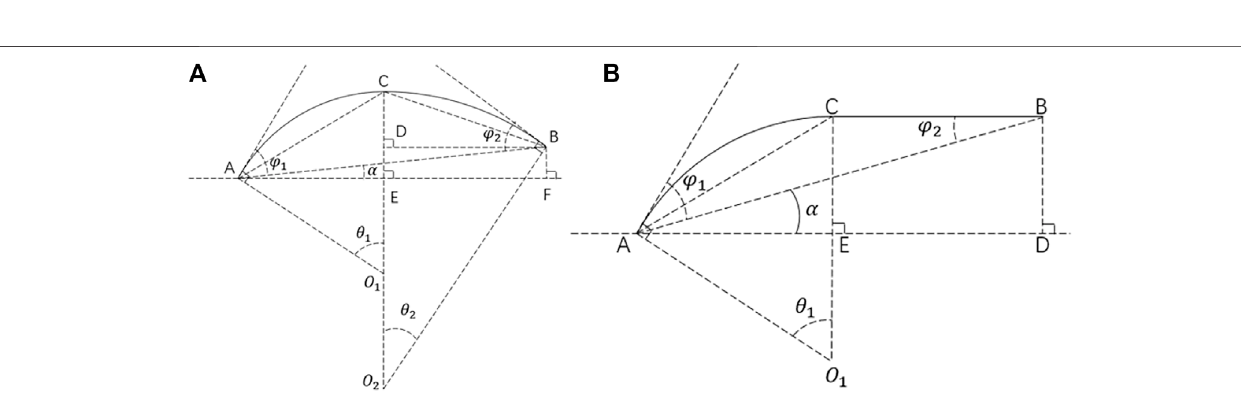
FIGURE 8 | Geometric sketch of the robot during (A) fi rst stage and (B) second stage.